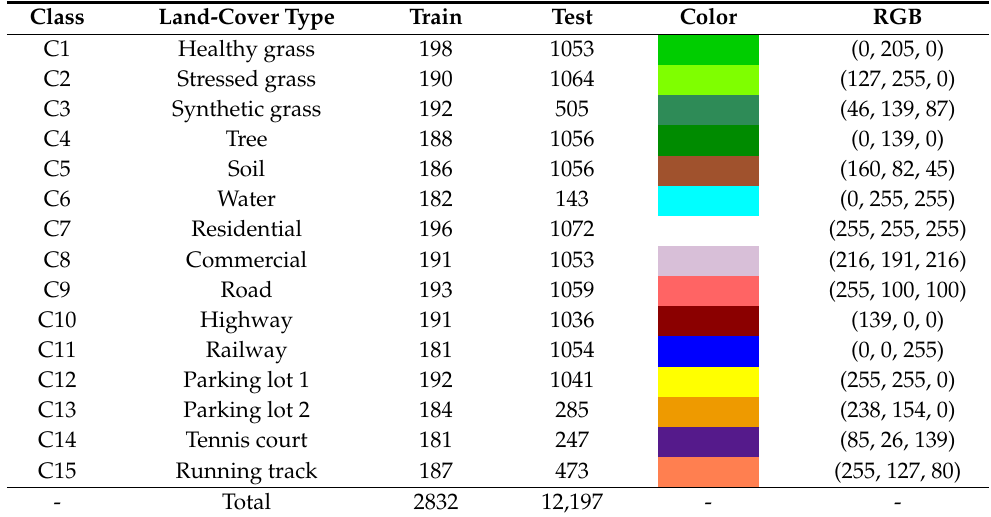
Table 1. The 2012 Houston data: numbers of training and testing sample, color and RGB value in each